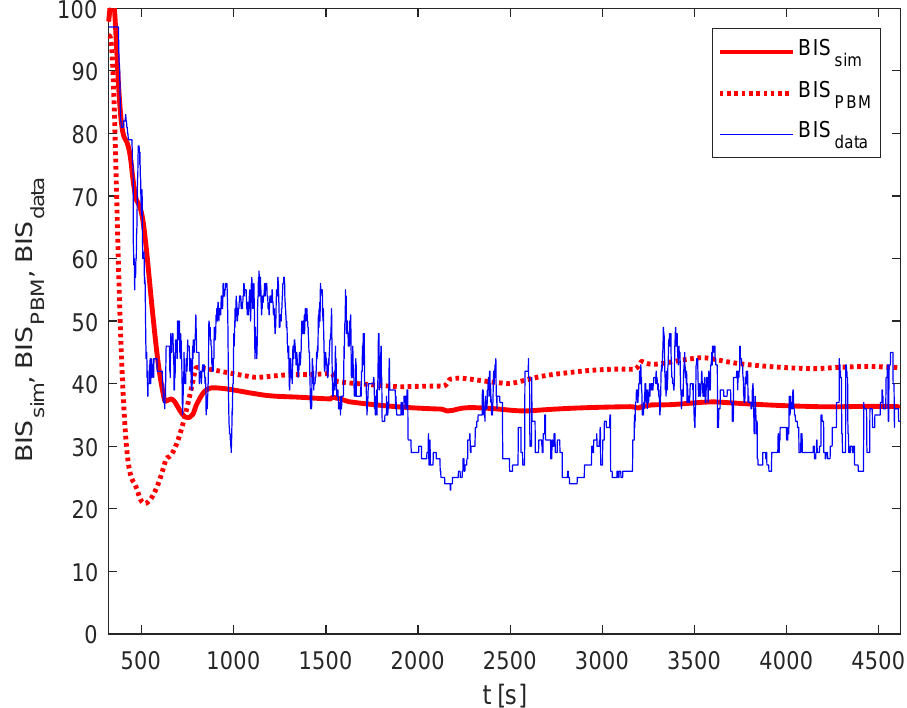
Figure 7. Improved model validation: BIS sim , BIS PBM , and BIS data